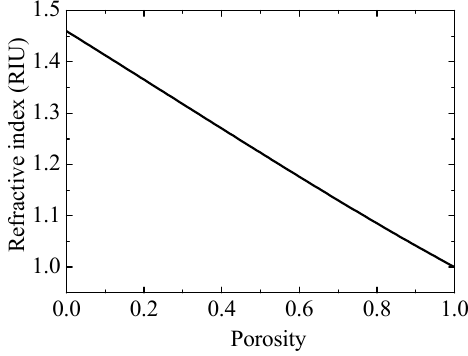
Figure 3. Refractive index as a function of the porosity of the porous silica film.